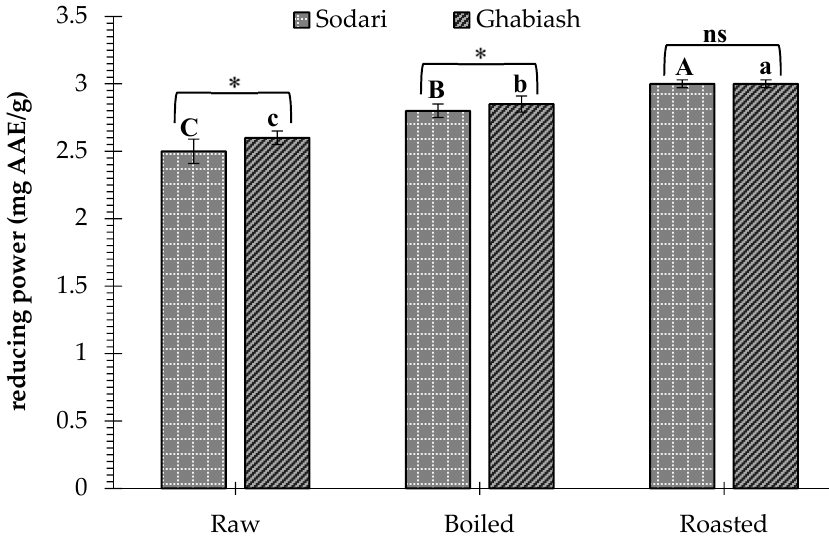
Figure 4. Effect of boiling and roasting on the reducing power of peanut cultivar shell. Data represent mean ± SD ( n = 3). Values followed by the same letter are not significantly different ( p < 0.05) as evaluated by LSD. Capital letters indicate significant differences between raw and processed samples of Sodari cultivars, whereas lower case letters indicate significant differences between raw and processed samples of Ghabiash cultivar. * shows the significant differences between means of cultivars, while ns shows the insignificant differences between means of cultivars in the raw and processed samples.